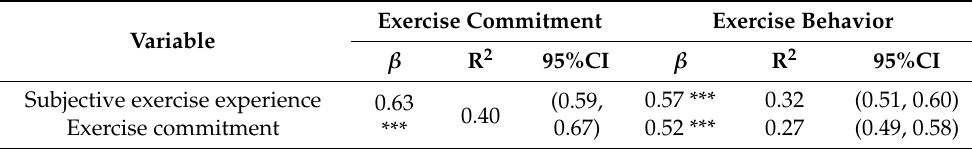
Table 4. Linear regression analysis among the subjective exercise experience, exercise commitment, and exercise